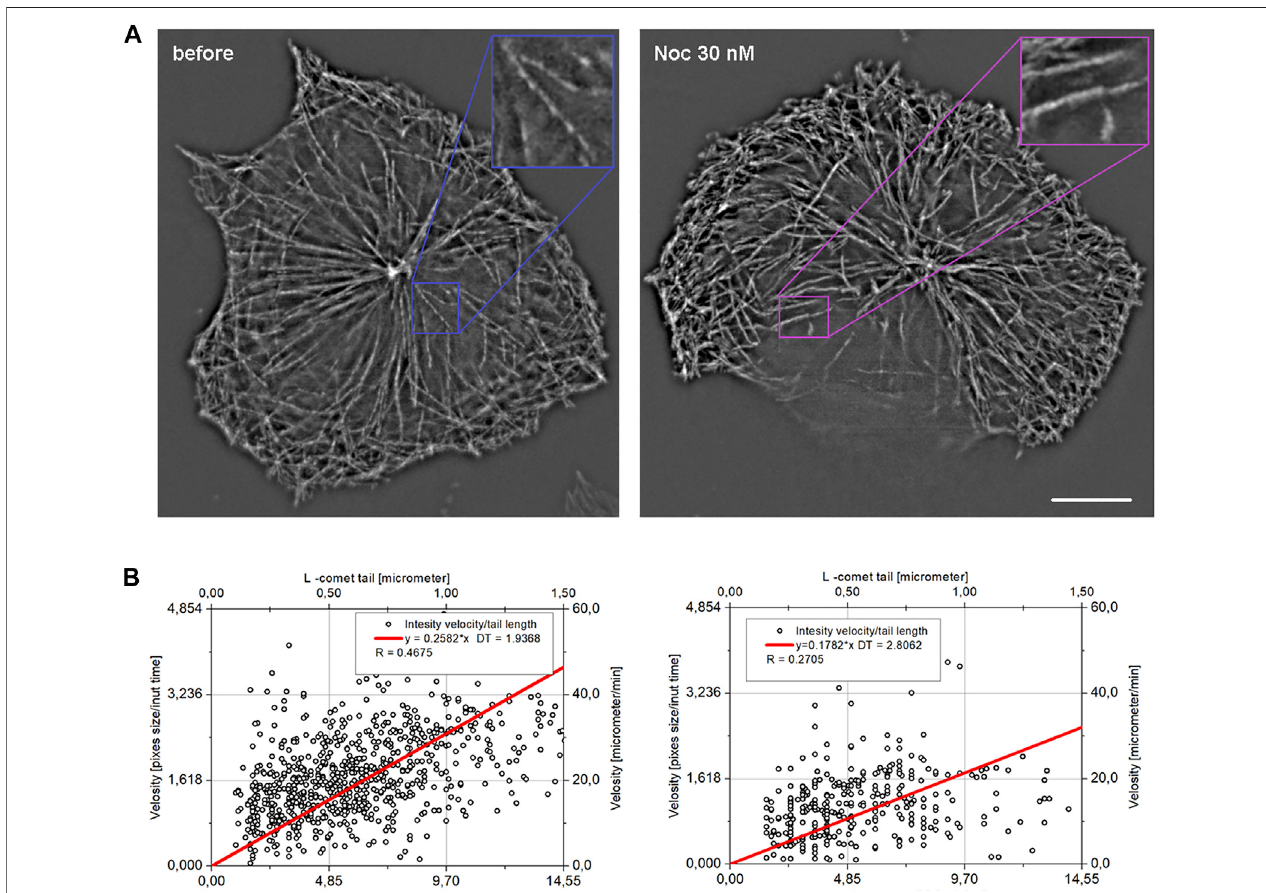
FIGURE 9 | Projections showing MT growth in HT 1080 (A) cells before and after treatment with nocodazole. Images were taken for 2-s intervals (each 4th frame) and merged as maximal intensity projection. In the internal cytoplasm, faster translocation of the EB comets in the control cell is evident (enlargement). The length – velocity correlation (B) for k (cid:1) 4 ( v k (cid:1) 4 versus L n+4 , 2 s interval) for control cells and cells after nocodazole treatment are